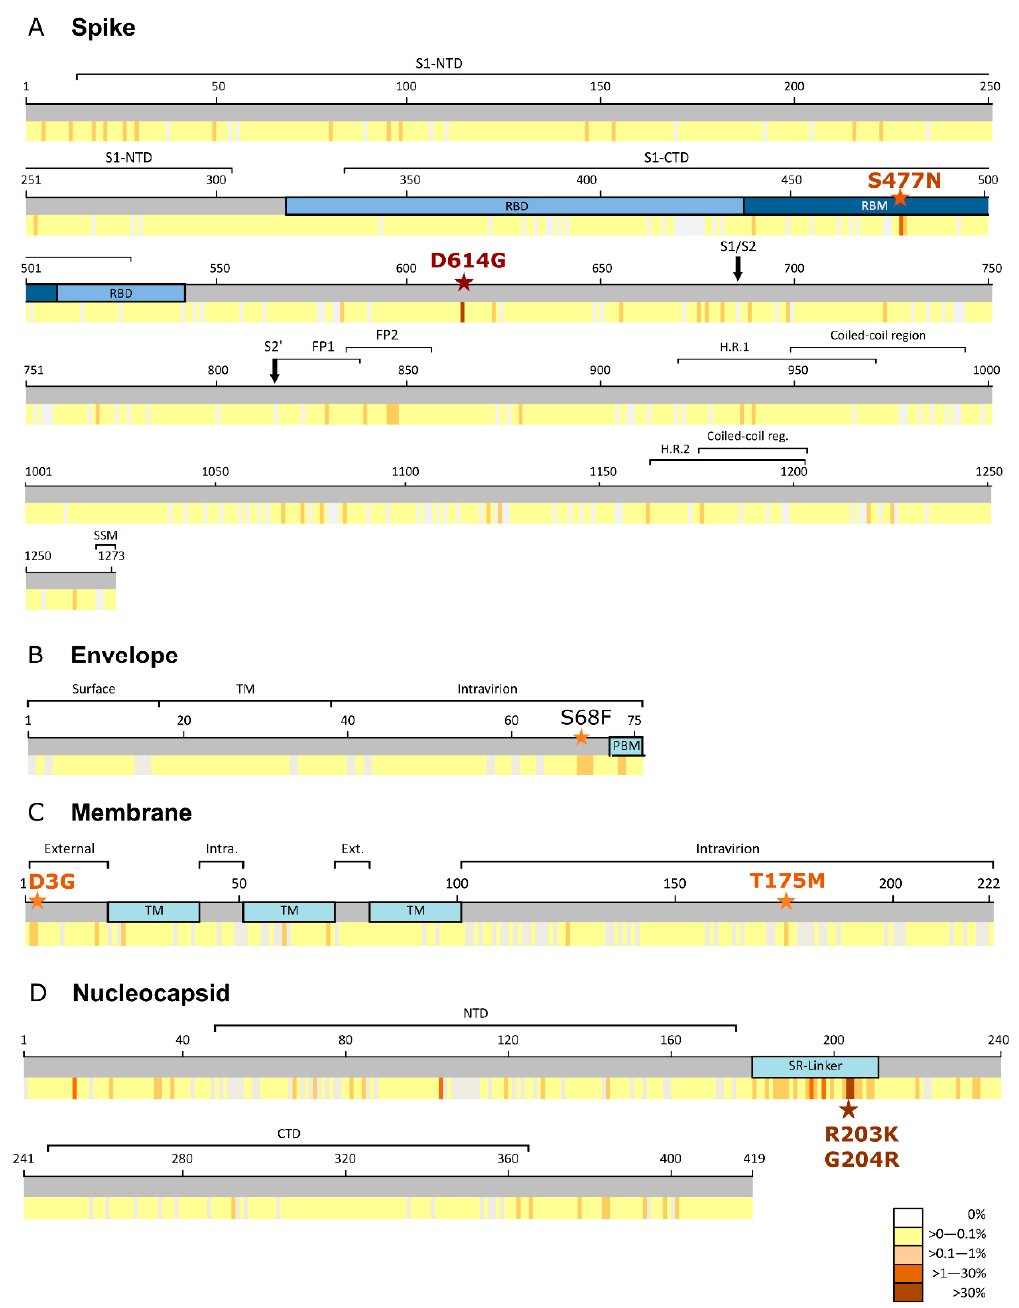
Figure 1. Percentage of global sequences with amino acids changes across the four SARS-CoV-2 structural proteins and their location in the protein domains. ( A ) Spike protein (1273 aa, 101,100 total sequences). With a brown star, D614G, change from aspartic acid to glycine in residue 614 of spike protein, present in 81.5% of the global sequences, and located in S1 domain, before S1/S2 furin cleavage site. With an orange star, S477N, change from serine to asparagine in residue 477, present in 4.1% of the global sequences, and located in the receptor binding motif. In light blue, receptor binding domain (RBD). In dark blue, within the RBD, receptor binding motif (RBM); ( B ) Envelope protein (75 aa, 101,376 total sequences). With an orange star, S68F, change from serine to phenylalanine at position 68 of envelope protein, present in 0.2% of the global sequences. In light blue, PDZ-binding motif (PBM); ( C ) Membrane protein (222 aa, 103,419 total sequences). With an orange star, D3G, change from aspartic acid to glycine in residue 3, and T175 M, change from threonine to methionine in residue 75. D3G and T175M were present in 0.7% and 1% global sequences, respectively. In light blue, transmembrane domains (TM); ( D ) Nucleocapsid protein (419 aa, 99,657 total sequences). With a brown star, R203K, change from arginine to lysine in position 203 and G204R change from glycine to arginine in position 204. R203K and G204R were present in 37.3% and 37% of the global sequences, respectively, and located in the serine/arginine-rich (SR)-